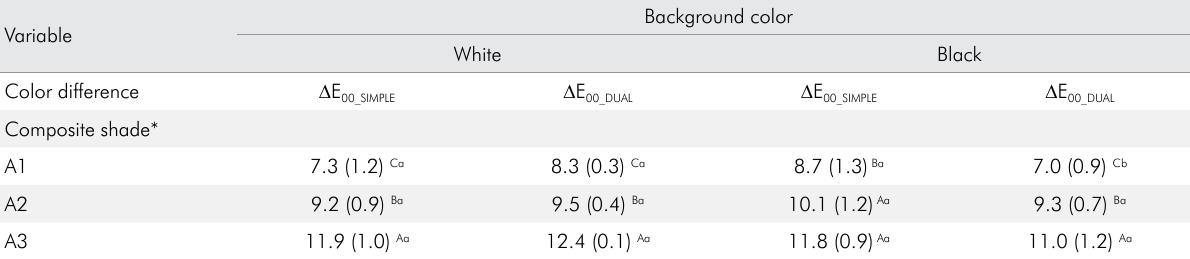
Table 3. Means (and standard deviations) for Δ E00 values for simple or dual specimens of the Vittra APS Unique composite compared with control